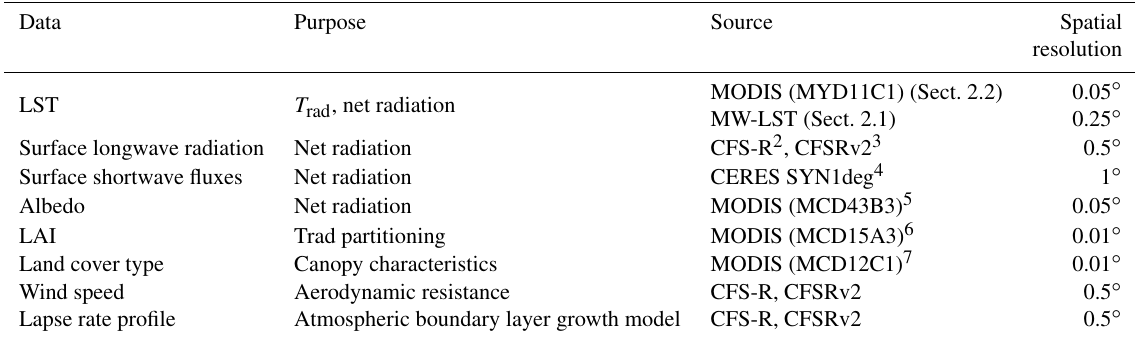
Table 1. Primary inputs for current global implementation of ALEXI.